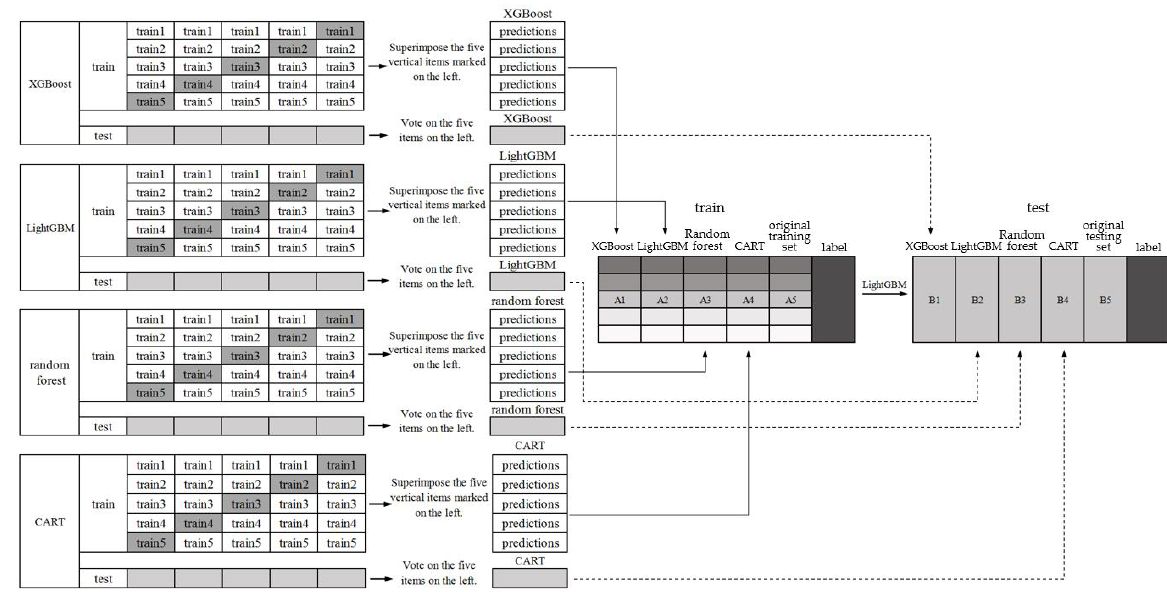
Figure 4. Construction process of stacking fusion model for grade